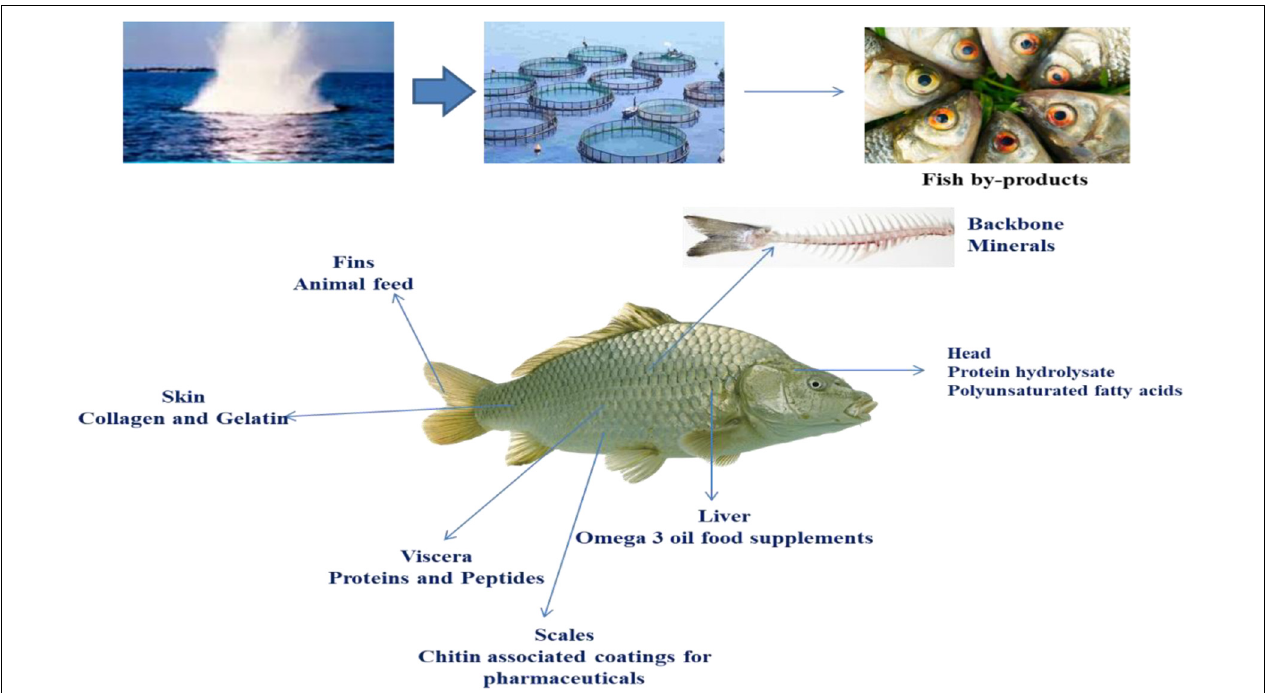
FIGURE 1 | Fish and its by-products as